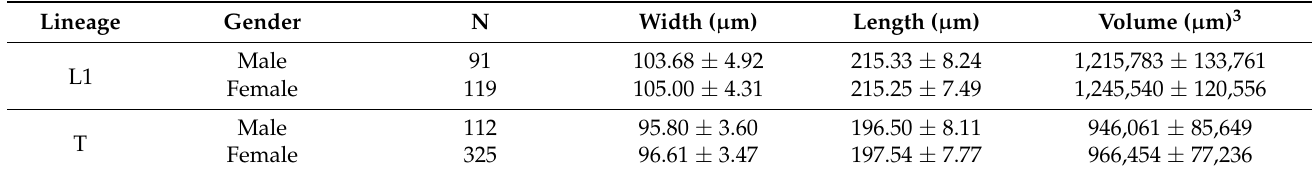
Table 2. Size of male and female eggs produced by mated mothers of the L1 and T lineages throughout the lifespan.